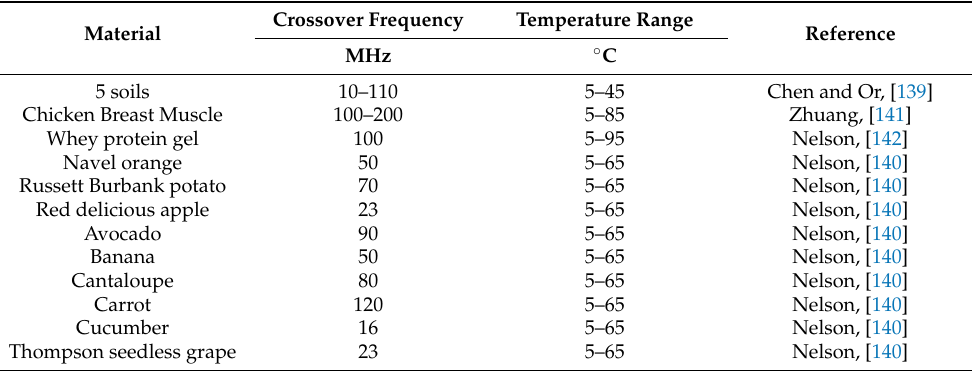
Table 5. Crossover frequencies of different materials observed from water content and temperature variations as a function of measurement